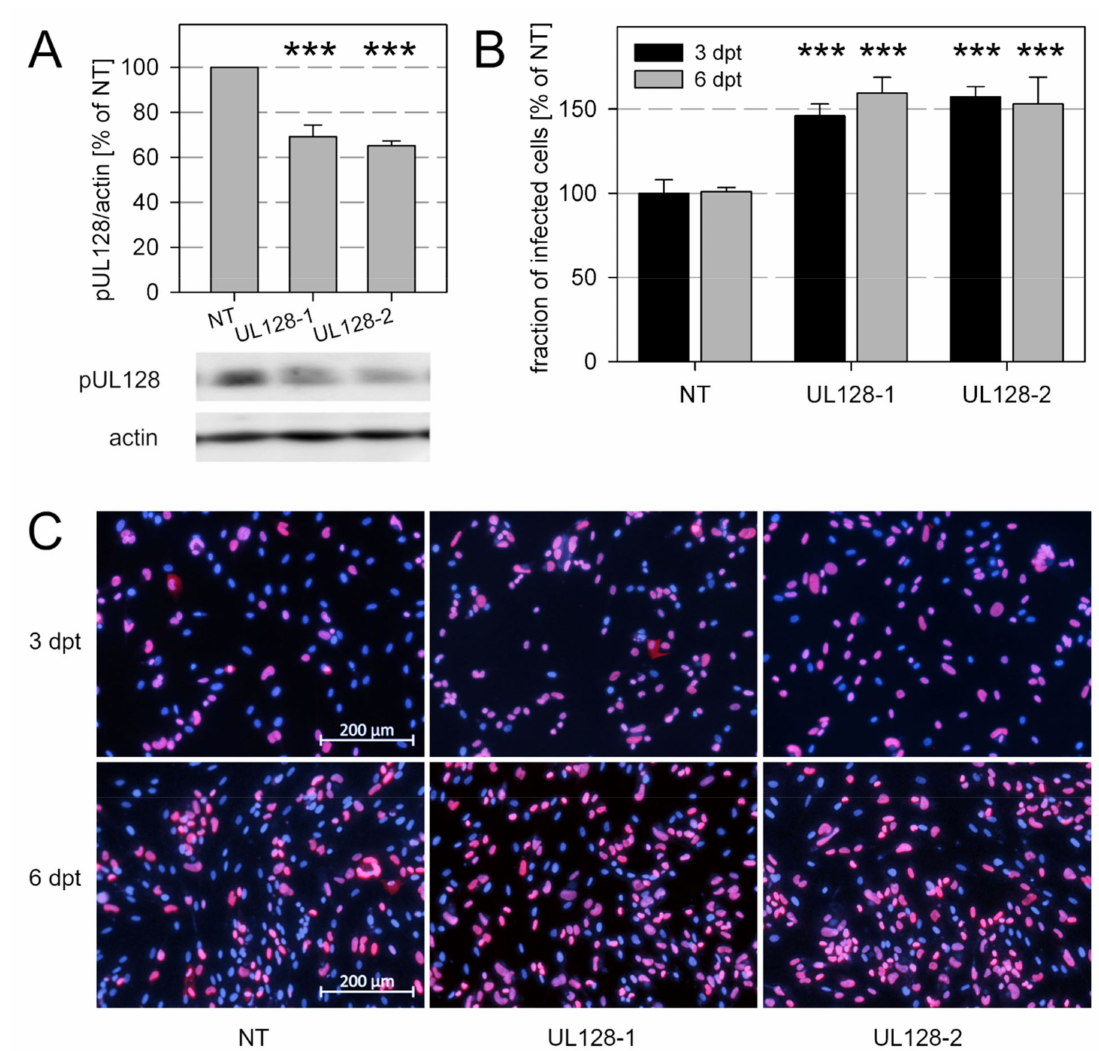
Figure 5. Knockdown of UL128 promotes growth of clinical HCMV isolates. Human fibroblasts, infected with recent HCMV isolates, were transfected with two individual siRNAs targeting transcripts of the viral gene UL128. Nontargeting siRNAs (NT) were included as a control. ( A ) Six days after transfection (dpt), cultures were lysed and analyzed by immunoblotting for expression levels of UL128, including detection of actin as a loading control. Chemiluminescence signals were analyzed by densitometry, and UL128/actin ratios were calculated and normalized to the NT controls. Bars indicate mean values of six replicates (three independent transfections with two isolates). Error bars represent the standard error of the mean (SEM). The asterisks indicate significant differences as compared with NT controls (***, p < 0.001). ( B ) Replicates of the transfected cultures were fixed 3 or 6 dpt and immunostained for viral immediate early (IE) antigen as a readout for viral growth. The fraction of infected cells was determined and normalized to the NT controls. Bars indicate mean values of six replicates (3 dpt: six technical replicates, 6 dpt: two independent transfections with three isolates). Error bars represent the standard error of the mean (SEM). The asterisks indicate significant differences as compared with NT controls (***, p < 0.001). ( C ) Representative examples of the immunostainings analyzed in Panel